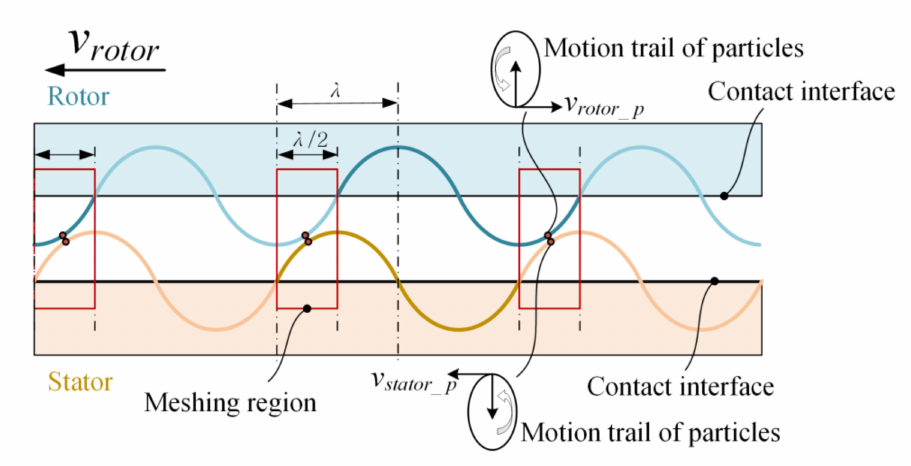
Figure 11. Meshing drive mechanism of double traveling